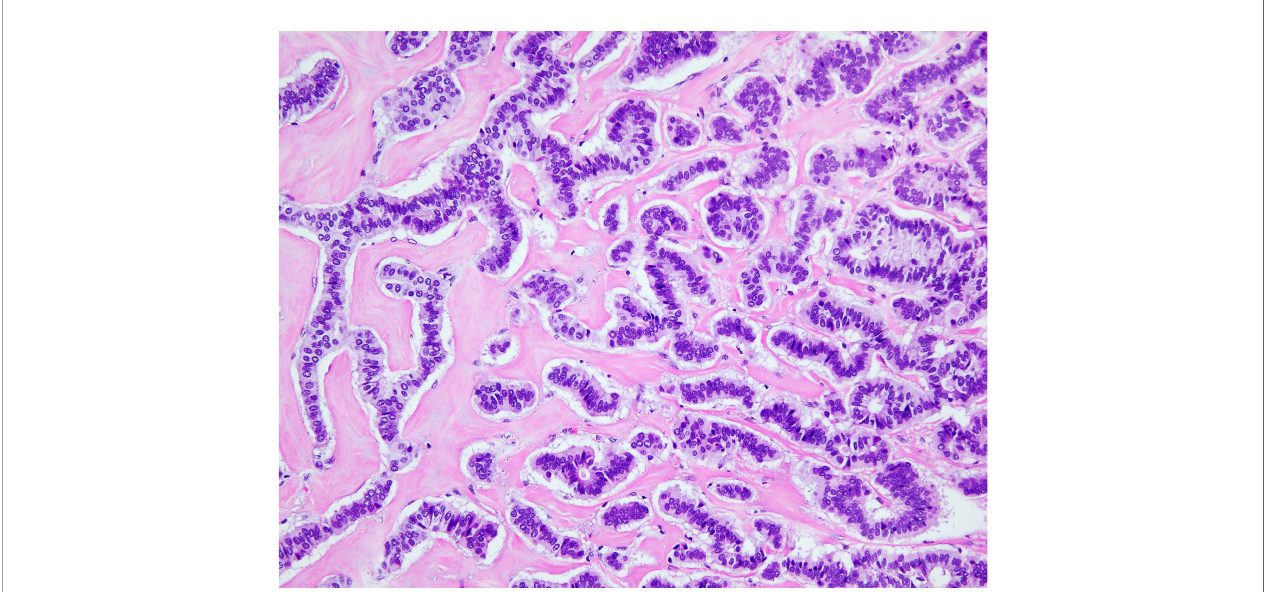
FIGURE 5 | NET foci in teratoma. Hematoxylin-eosin staining, zoom 20x. Long parallel ribbons and small islands and nests of cells with eosinophilic cytoplasm and oblong nuclei oriented perpendicular to main axis of ribbons.